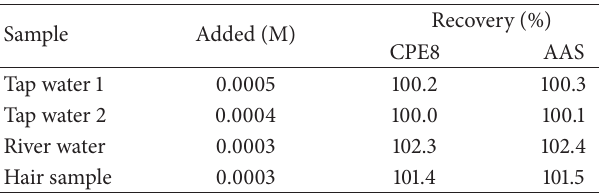
Table 5: Recovery of Tl(I) ion by CPE8 from different water sam-